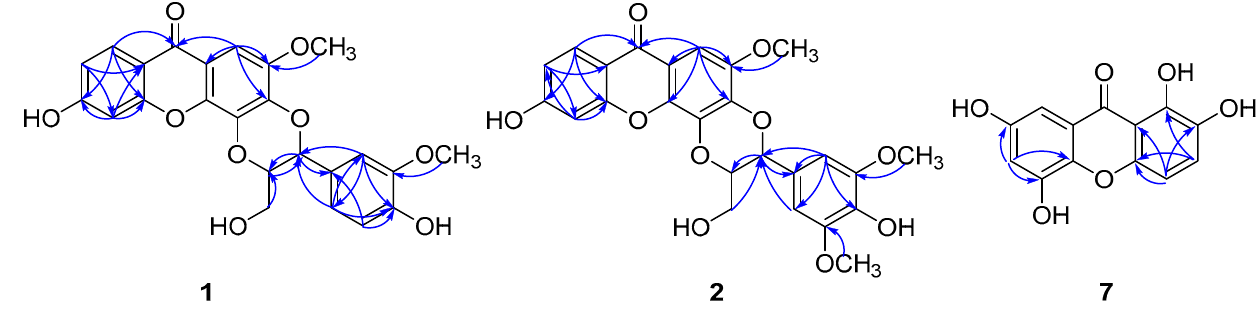
Figure 2. Selected HMBC (arrow) correlations of compounds 1, 2 and 7 .